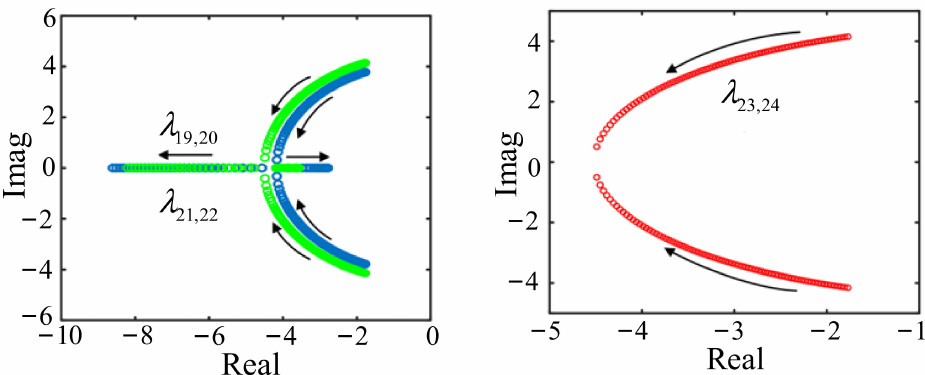
Figure 11. Eigenvalue trajectories of the system under different damping